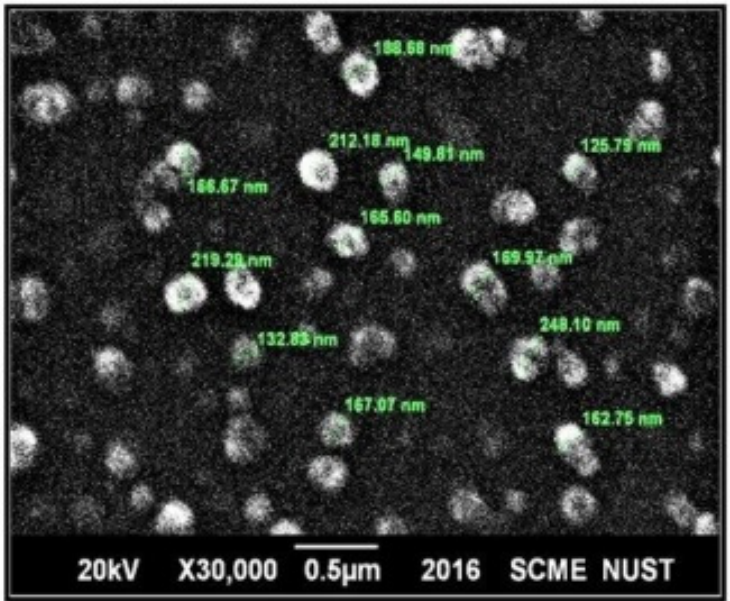
Figure 5. SEM image of regenerated liquid nanoemulsion developed from formulation (21).